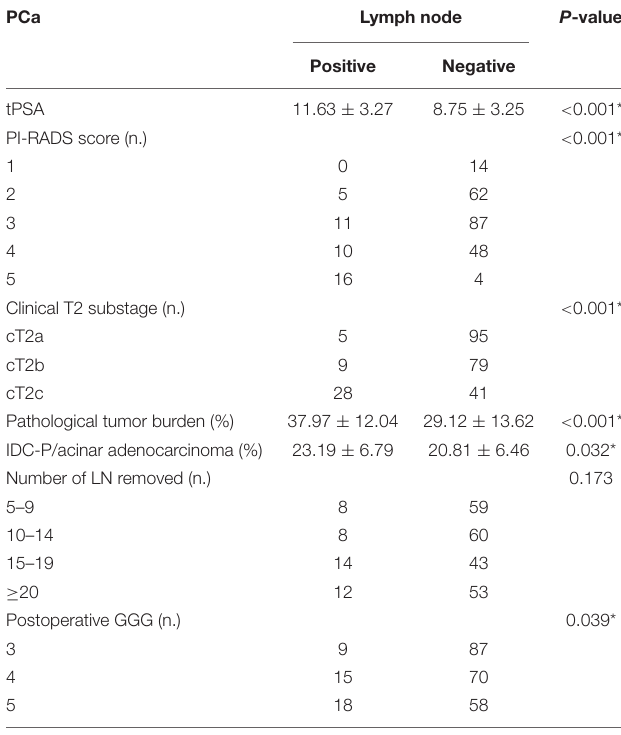
TABLE 3 | Comparison of clinicopathological characteristics between pLN( + ) and pLN( − ) in patients with postoperative GGG ≥